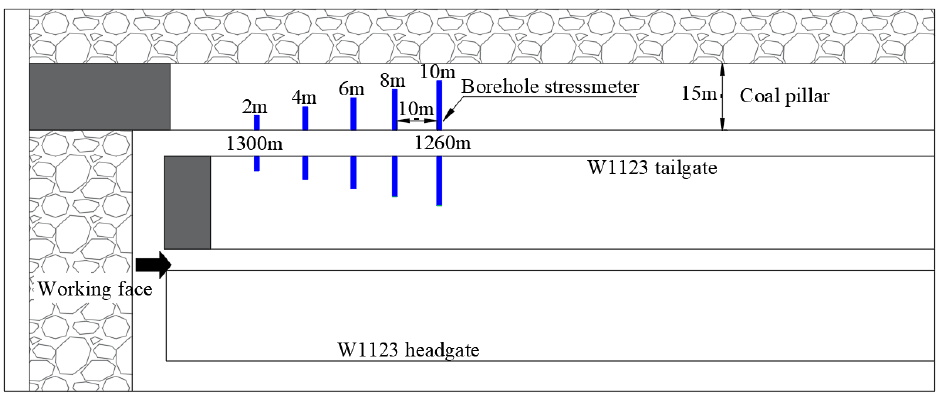
Figure 17. Layout of the stress monitoring points.